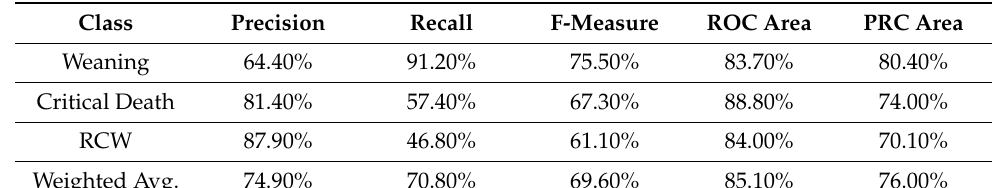
Table 4. C4.5 algorithm performance for Model I with five basic attributes.